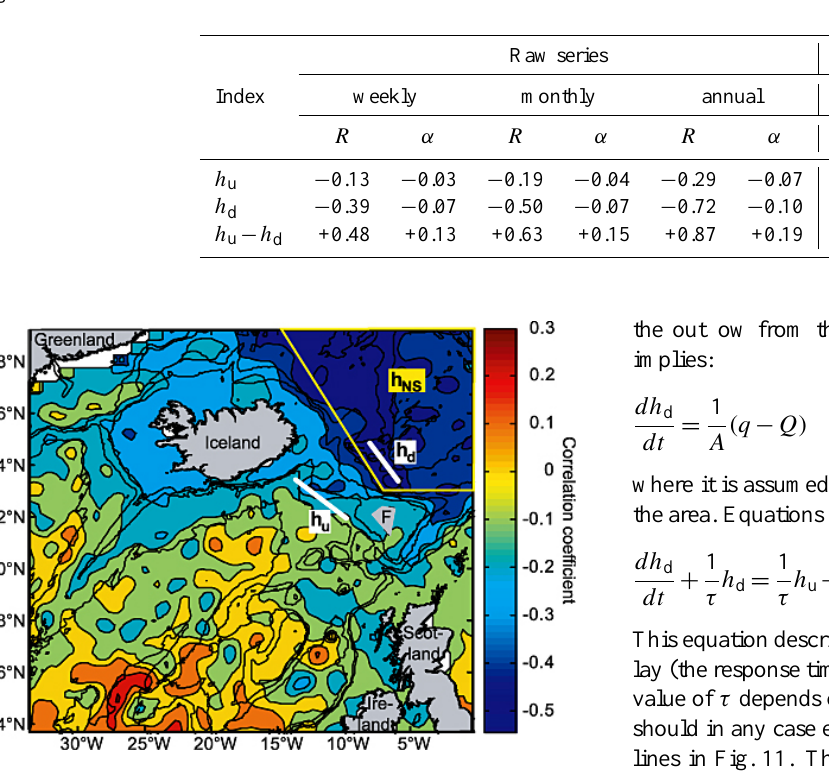
Fig. 11. Correlation coefficients between monthly averaged IF- inflow and SLH in altimeter grid points. White lines indicate grid points used for defining h u and h d , respectively and the area bounded by yellow lines is the Nordic Seas region, over which the average SLH, h NS , was computed. Land areas are gray with an “F” indicating the Faroe Islands and bottom contours are shown by black